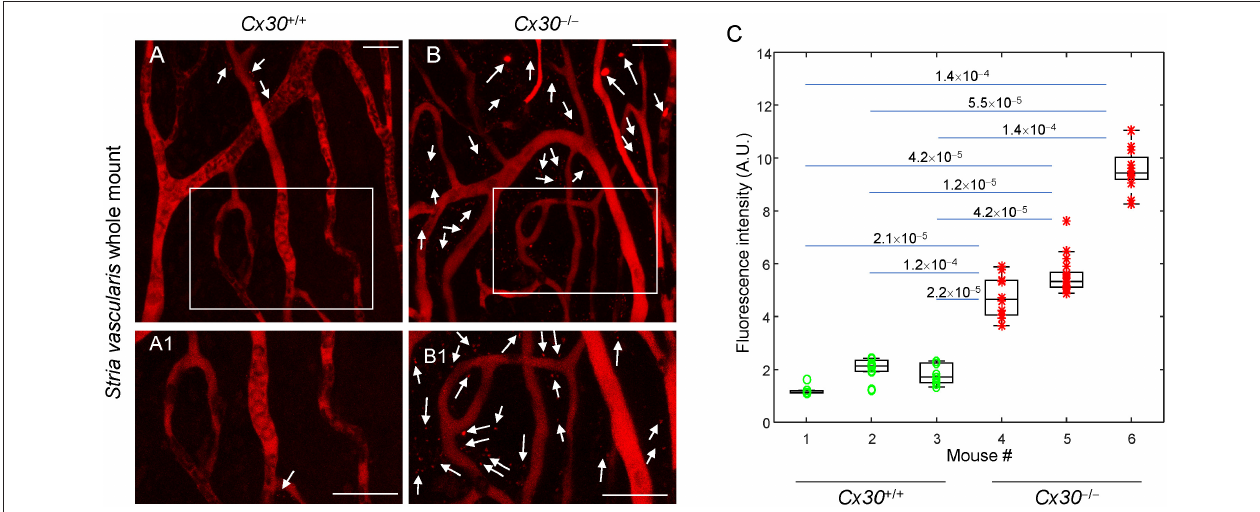
FIGURE 6 | Vascular dysfunction in Cx30 − / − adult mice. (A,B) Representative images of freshly explanted SV from Cx30 + / + and Cx30 − / − mice (3 months of age) injected with a fluorescent Texas Red dextran (MW 70,000). Regions in the boxed areas are shown magnified in (A1,B1) . Arrows indicate dye lumps that leaked out of the vessels Cx30 − / − . Scale bars: 30 µ m. (C) Quantification of Texas Red dextran fluorescence intensity (AU, arbitrary units) in SV of Cx30 + / + and Cx30 − / − samples. Data analysis was performed on n = 3 mice of each genotype; numbers above horizontal bars indicate p -values that were determined by the Mann–Whitney U -test, as implemented in the MATLAB function ranksum . Through-focus image sequences (z-stacks) corresponding to the images shown in this figure are provided as Supplementary Video 1 ( Cx30 + / + ) and Supplementary Video 2 ( Cx30 − / −